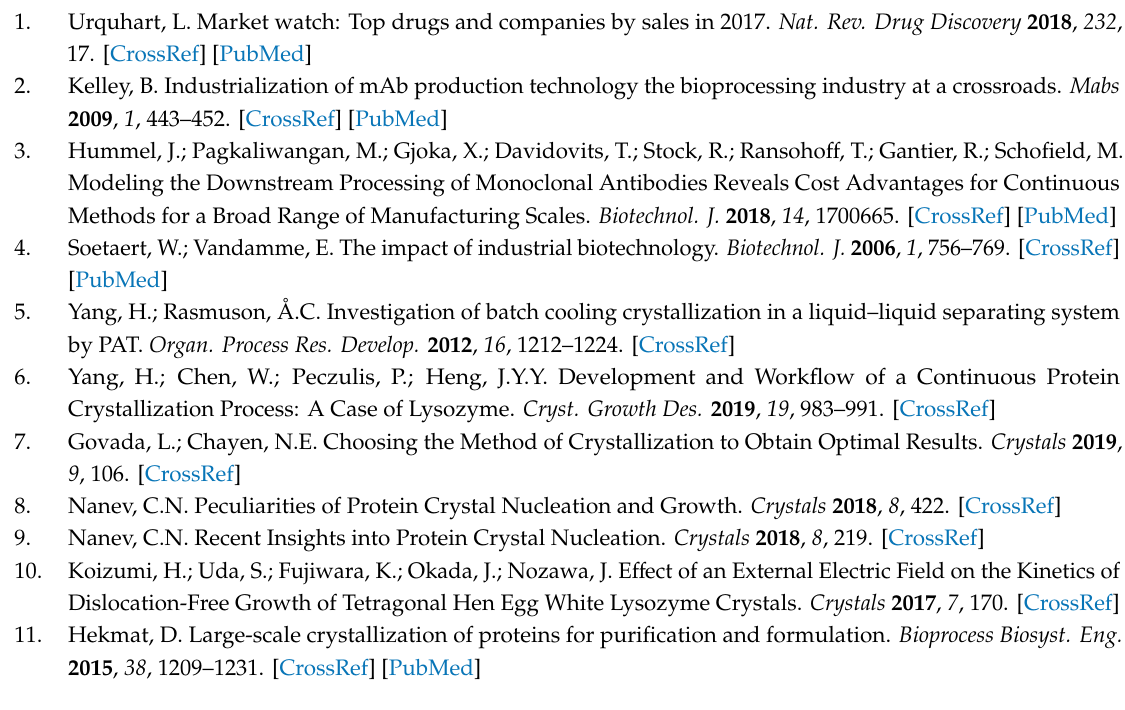
Figure S1: Size Exclusion Chromatography for anti-CD20 from washed and dissolved crystals (solid line) and from pristine solution (dashed line) (a). SDS-PAGE electrophoresis performed on-washed and dissolved crystals (b); Figure S2: Powder di ff raction profiles calculated at the same wavelength (2.06642 Å) from the crystal structure of (a) sodium citrate (CCDC code 1478189) and (b) Fc fragment of human immunoglobulin G1 (PDB code 3AVE). Molecules are shown in stick-and-ball (a) and cartoon (b) representations. Di ff raction reflections are indicated by lines below the 2q axis; Table S1: Mascot analysis of peptide fingerprint of digested band from anti-CD20 crystals. Only the sequence showing the best match with experimental data is